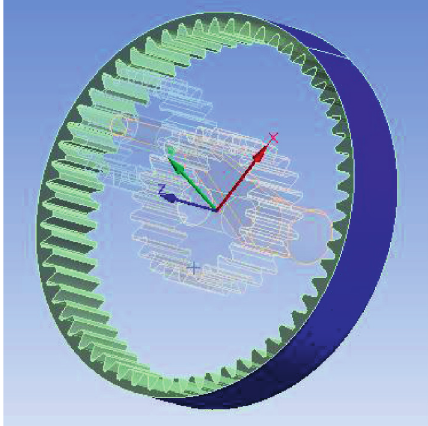
Figure 12: Fixed pair of inner gear ring to ground.